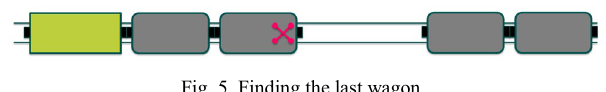
Fig. 5. Finding the last